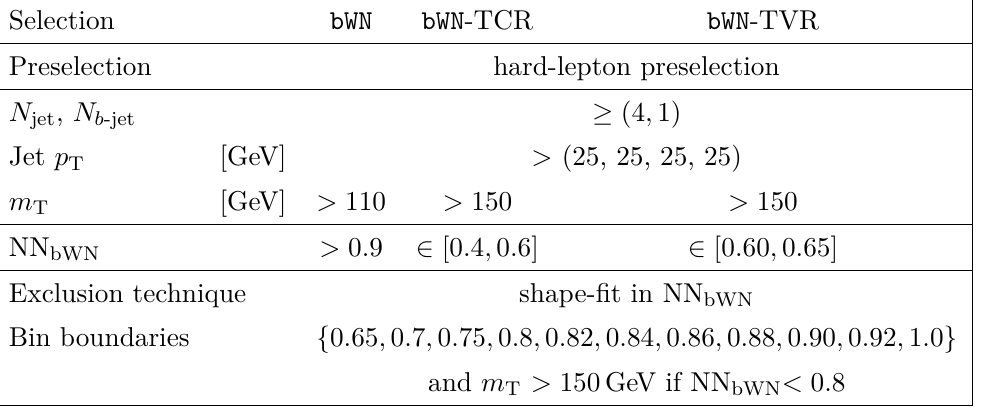
Table 6. Event selections defining the signal region bWN , along with its CR and